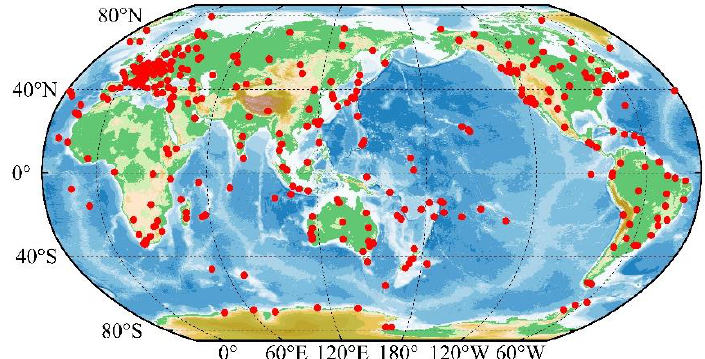
Figure 1. Distribution of the 436 IGS stations (red points).